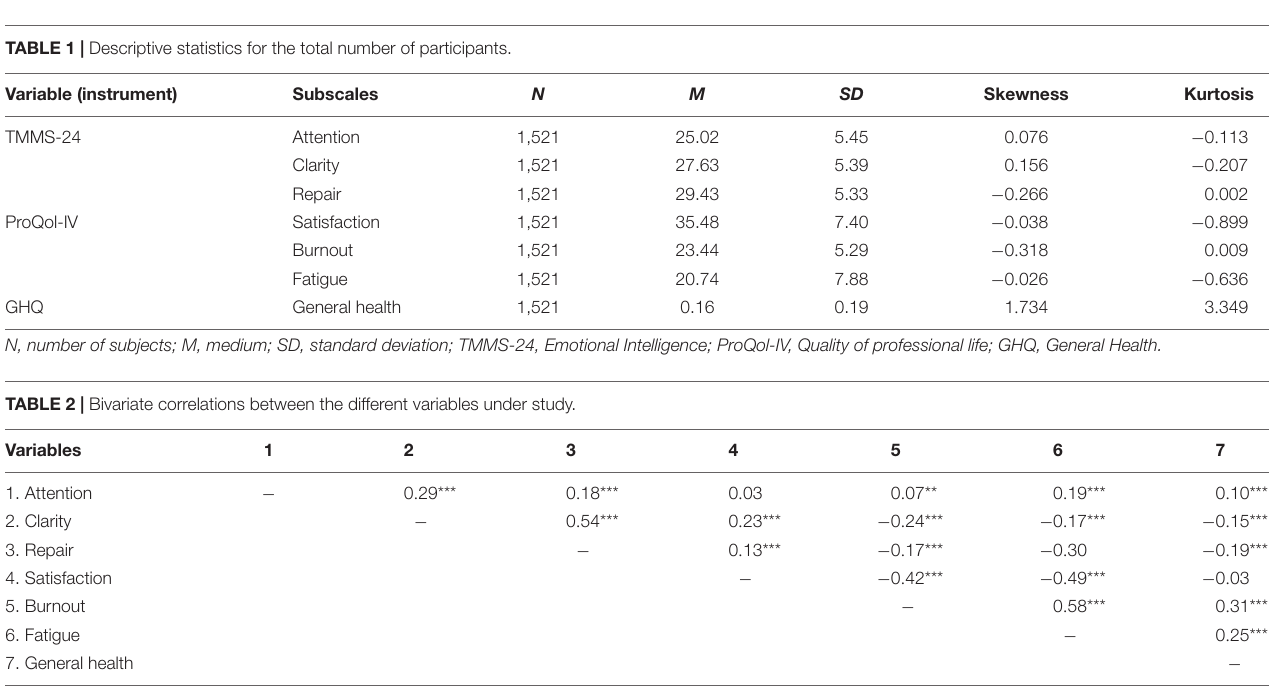
Table 4 reflects the results of predicting the variables of emotional intelligence and general health, controlling for gender and age. If we look at step two, the EI variables such as attention, clarity and repair helped explain 10% of compassion fatigue. Incorporation into the health model (step three) increased the explained variance of compassion fatigue by 12%. In fact, considering all the psychological variables considered in the model, it can be seen that clarity dimension was shown to be the greatest predictor of fatigue ( β = − 0.28, p < 0.001) and attention dimension ( β = 0.22, p < 0.001).